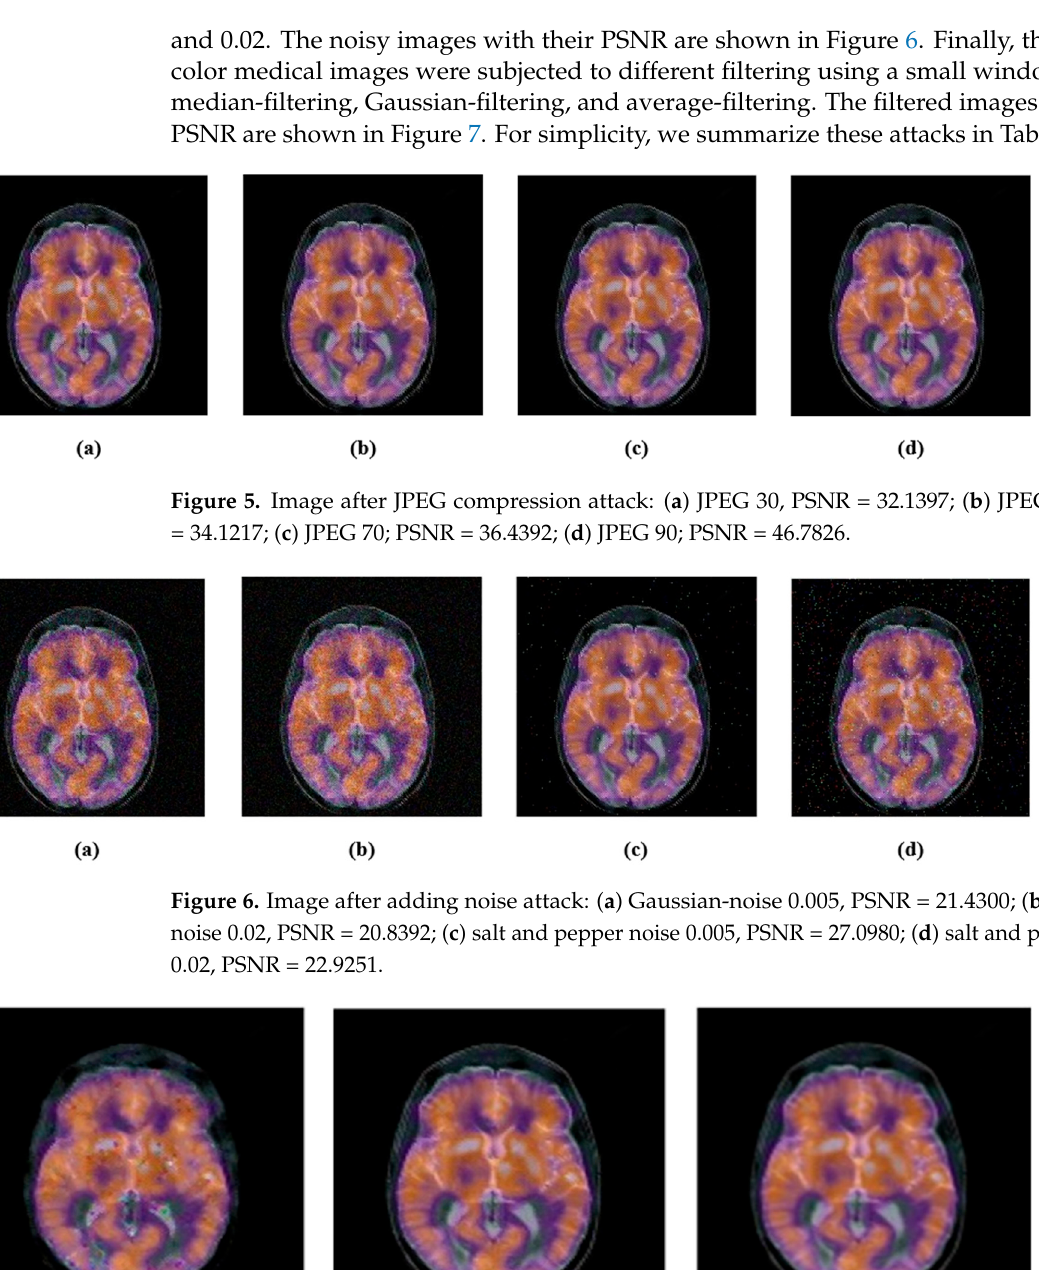
Table 1. Common image processing attacks and their parameterization.